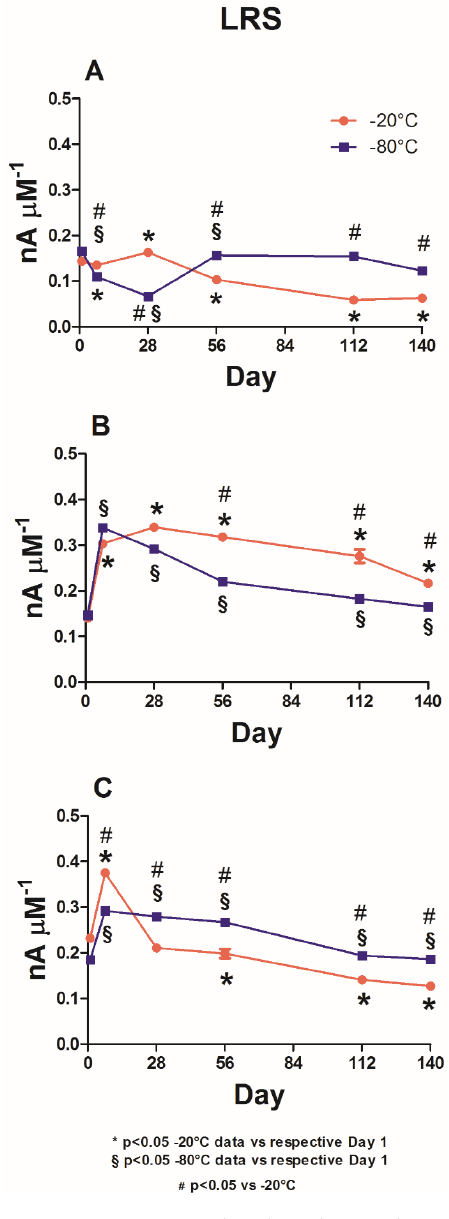
Figure 5. Graph describing the variations of LRS in the different biosensor groups: control (Pt c /PPD/PEI(1%) 2 /GlutOx 5 ; Panel ( A )), glycerol-loading group (Pt c /PPD/PEI(1%) 2 /GlutOx 5 /GLY(1%); Panel ( B )) and triethylene glycol-group (Pt c /PPD/PEI(1%) 2 /GlutOx 5 /TEG(1%); Panel ( C )) over a range of 140 days when stored at −20 °C (red plot) and −80 °C (blue plot). The subscript number represents the number of deposition steps, while the brackets report the concentrations of the component. Pt c : Pt cylinder 1 mm long, 125 µm in diameter; GluOx: L-glutamate oxidase; PPD: poly-ortho-phenylenediamine; PEI: polyethylene- imine; GLY: glycerol; TEG: triethylene glycol.